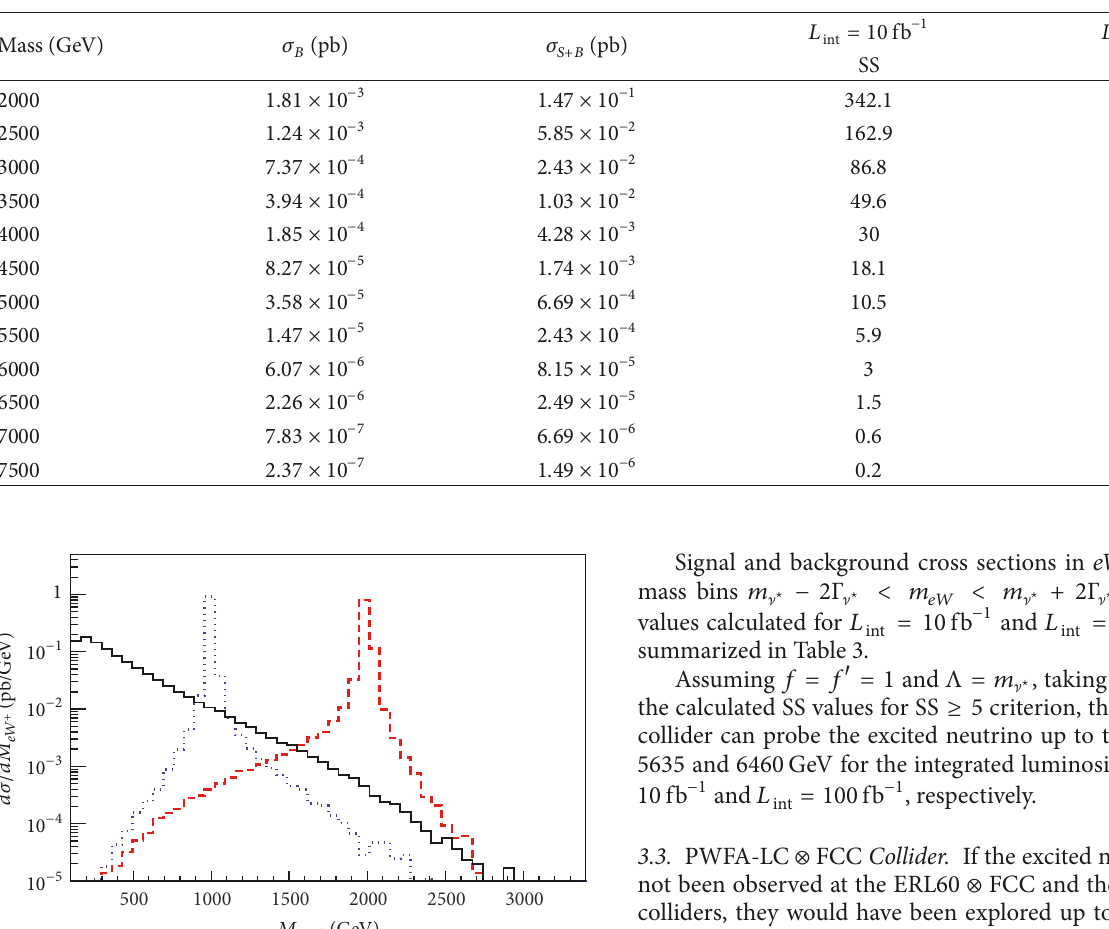
Table 3: The statistical significance (SS) values and the cross sections of the excited neutrino signal and relevant background at the ILC ⊗ FCC collider with √𝑠 = 10 TeV assuming the coupling 𝑓 = 𝑓 󸀠 = 1 and the energy scale Λ = 𝑚 ] ⋆ .